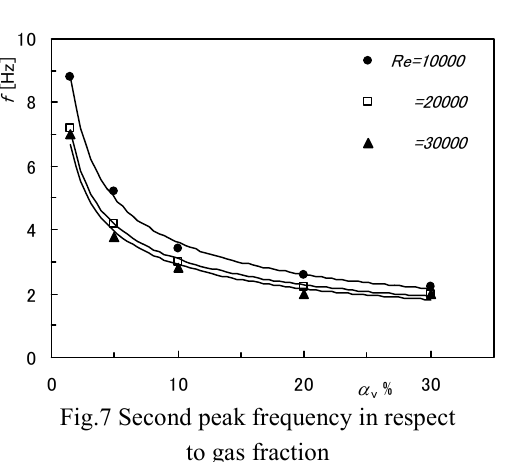
Fig.6 FFT analysis for normal expansion ( Re =1.0 × 10 4 and α